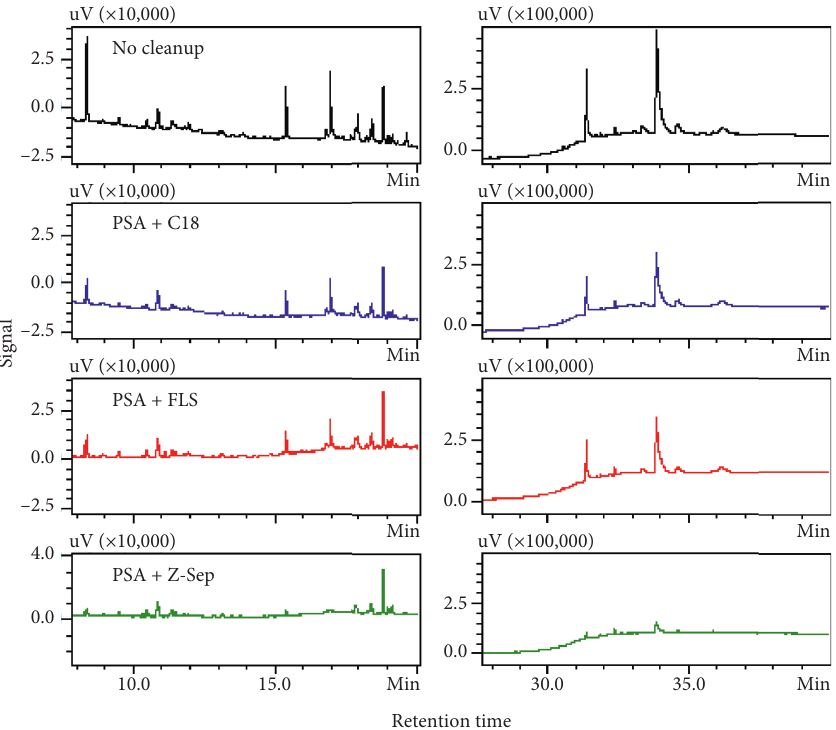
Figure 4: Matrix background of ginseng samples purified using different strategies indicated by